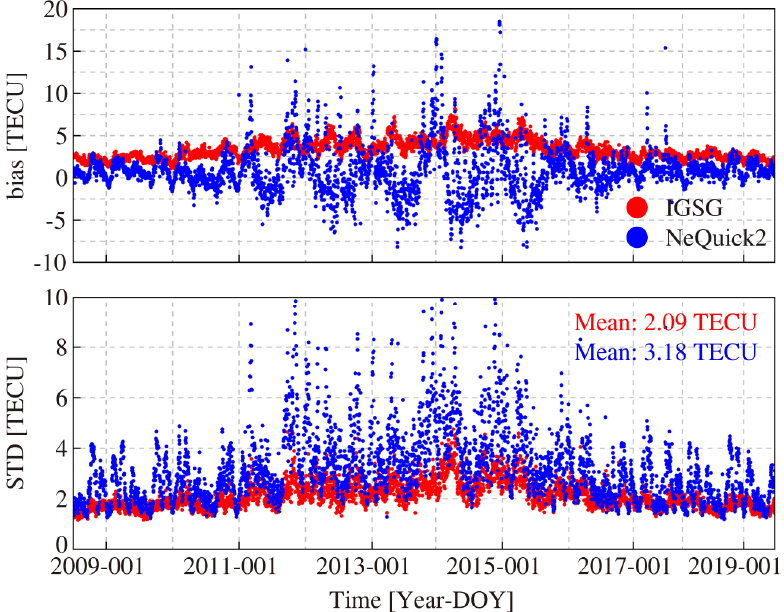
Figure 8. Time series of IGSG and NeQuick2 with respect to Jason2 VTEC during the test period.